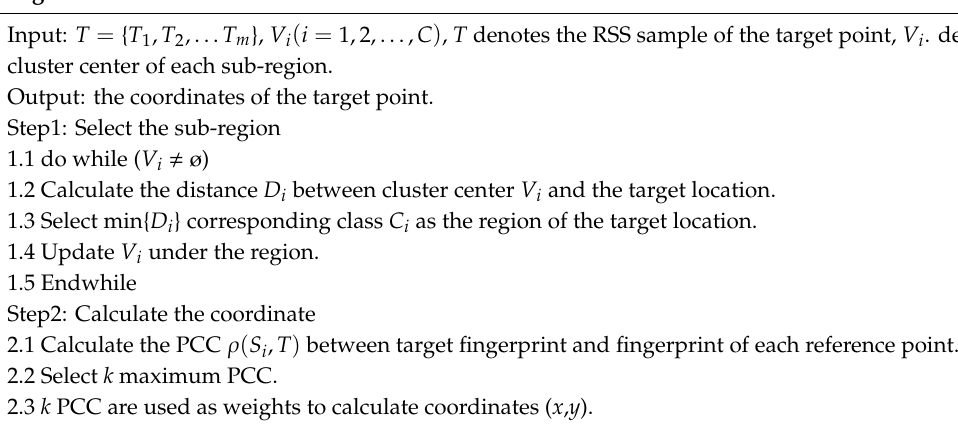
Algorithm 2. Localization Method